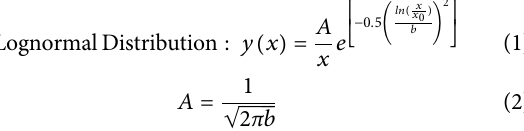
TABLE 1 | Solubility parameter differences between drugs, BCP blocks, and water determined from HSP values in Supplementary Table S1 . Compound